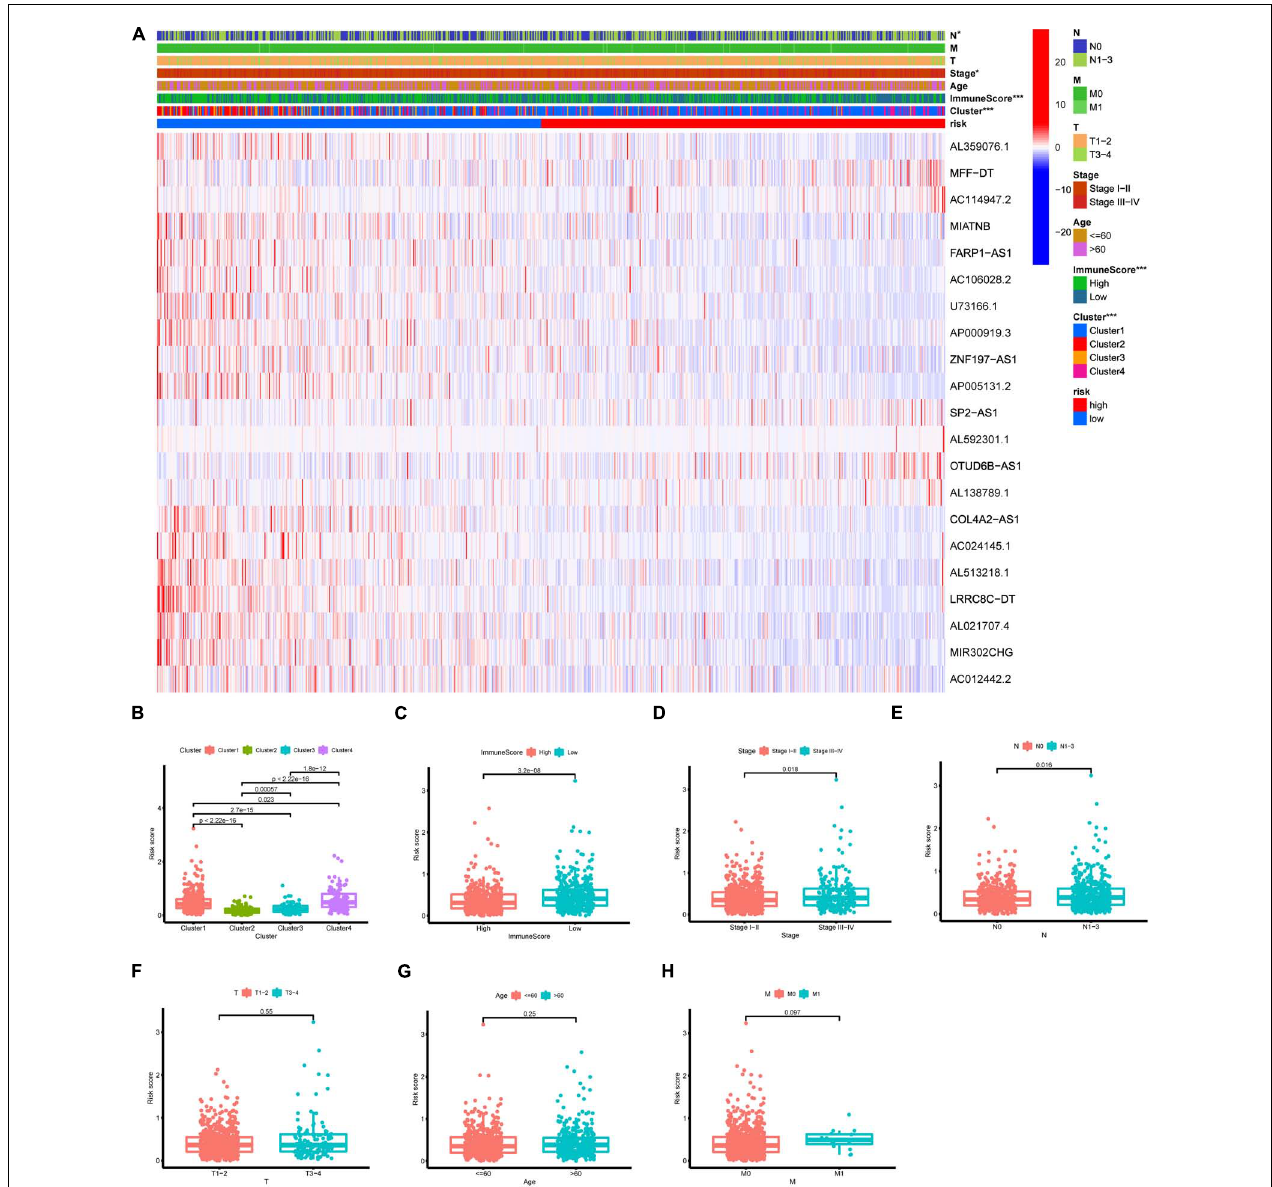
FIGURE 7 | Clinical evaluation by the m6A-LncRM signature. (A) A strip heatmap along with the scatter diagram showed that clinical stage, BC clusters, and ImmuneScore were significantly associated with the riskScore. (B–H) BC patients with different clinicopathological features including m6A-LncRNA clusters, ImmuneScore, tumor stage, node status, tumor size, patient age, and metastasis status had different levels of risk scores.